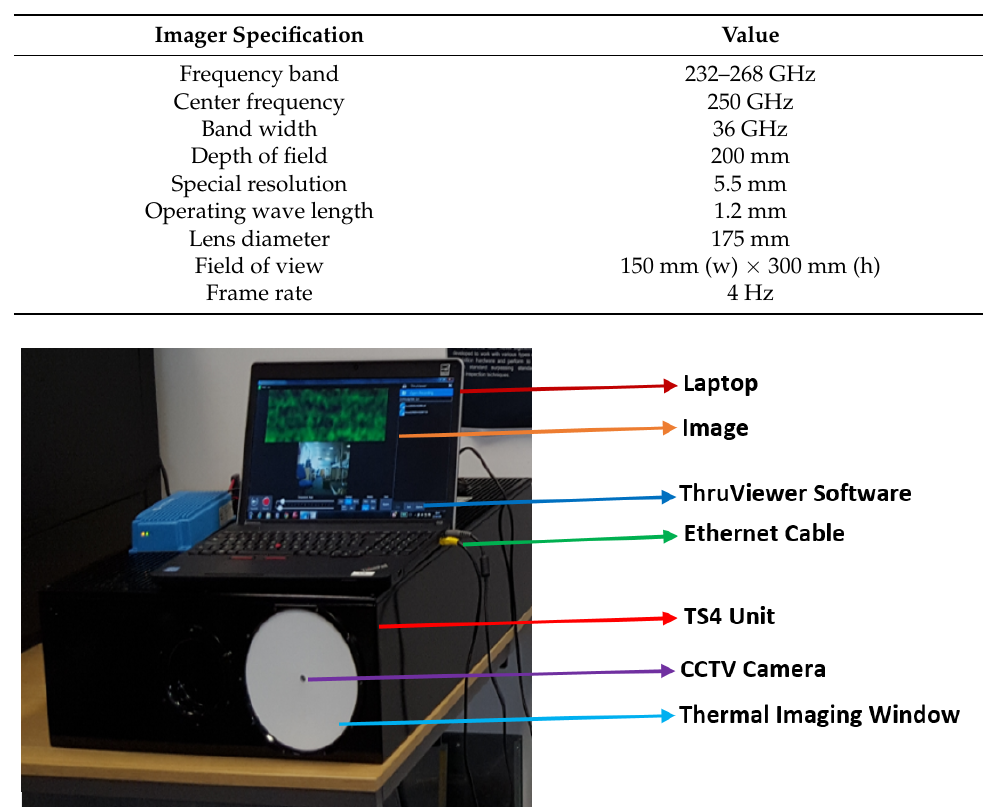
Table 1. A ThruVision passive imager specifications and parameters [49].